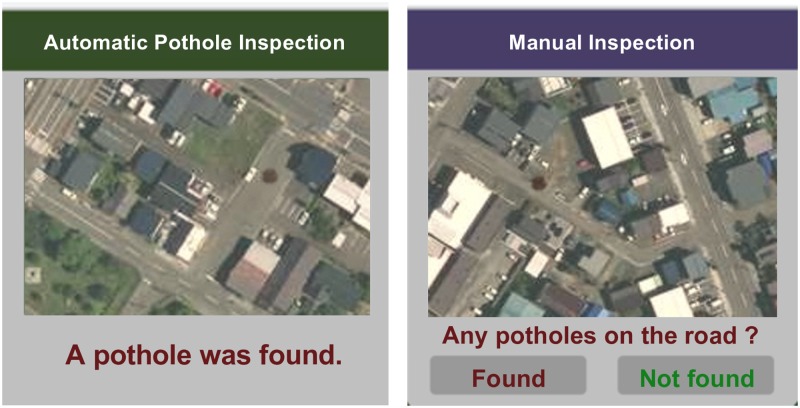
Popup windows of the pothole inspections.(A) Automatic inspection result window. (B) Manual inspection window. Both images contain potholes as dark brown spots in the upper road areas. Geospatial Information Authority of Japan (https://maps.gsi.go.jp) CC BY 4.0. The images are similar but not identical to the original ones used in the experiment due to a copyright reason. Potholes were artificially rendered as irregular shapes in a dark brown color on a road image in the popup window.